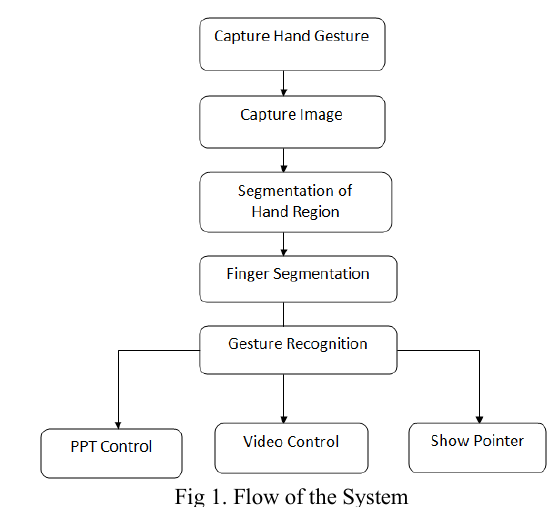
Fig 1. Flow of the